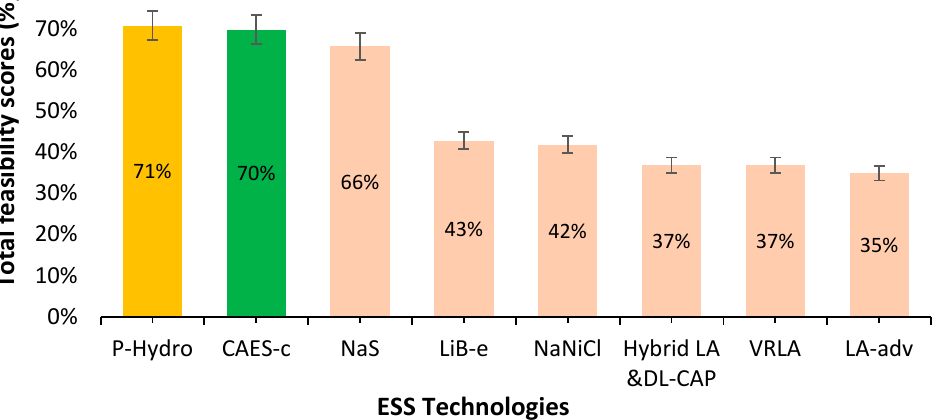
Figure 6. Analysis of total scores meeting ALCM criteria of different ESS applicable at central or bulk storage for a weight factor of 1.